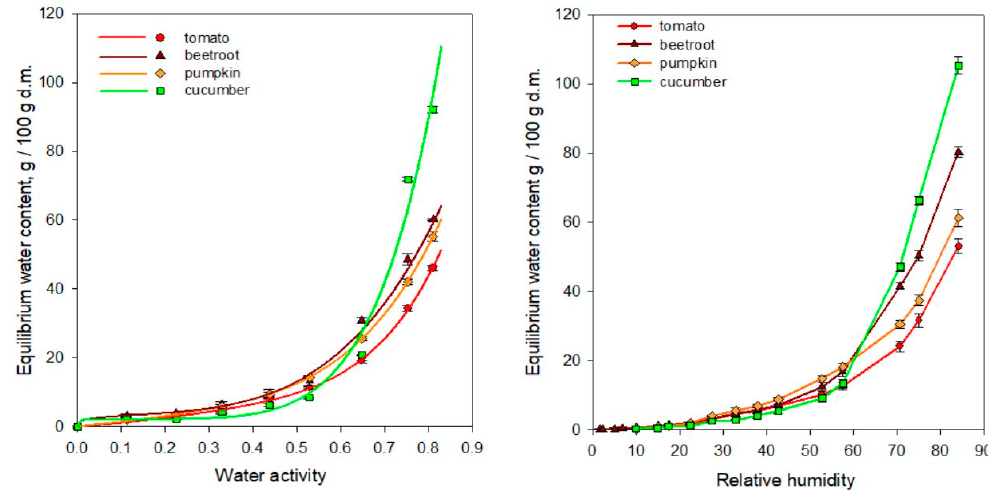
Figure 4. Sorption isotherms of different freeze-dried soups obtained using: ( a ) a static method (lines—Peleg model); ( b ) a dynamic vapor sorption method (DVS) method.